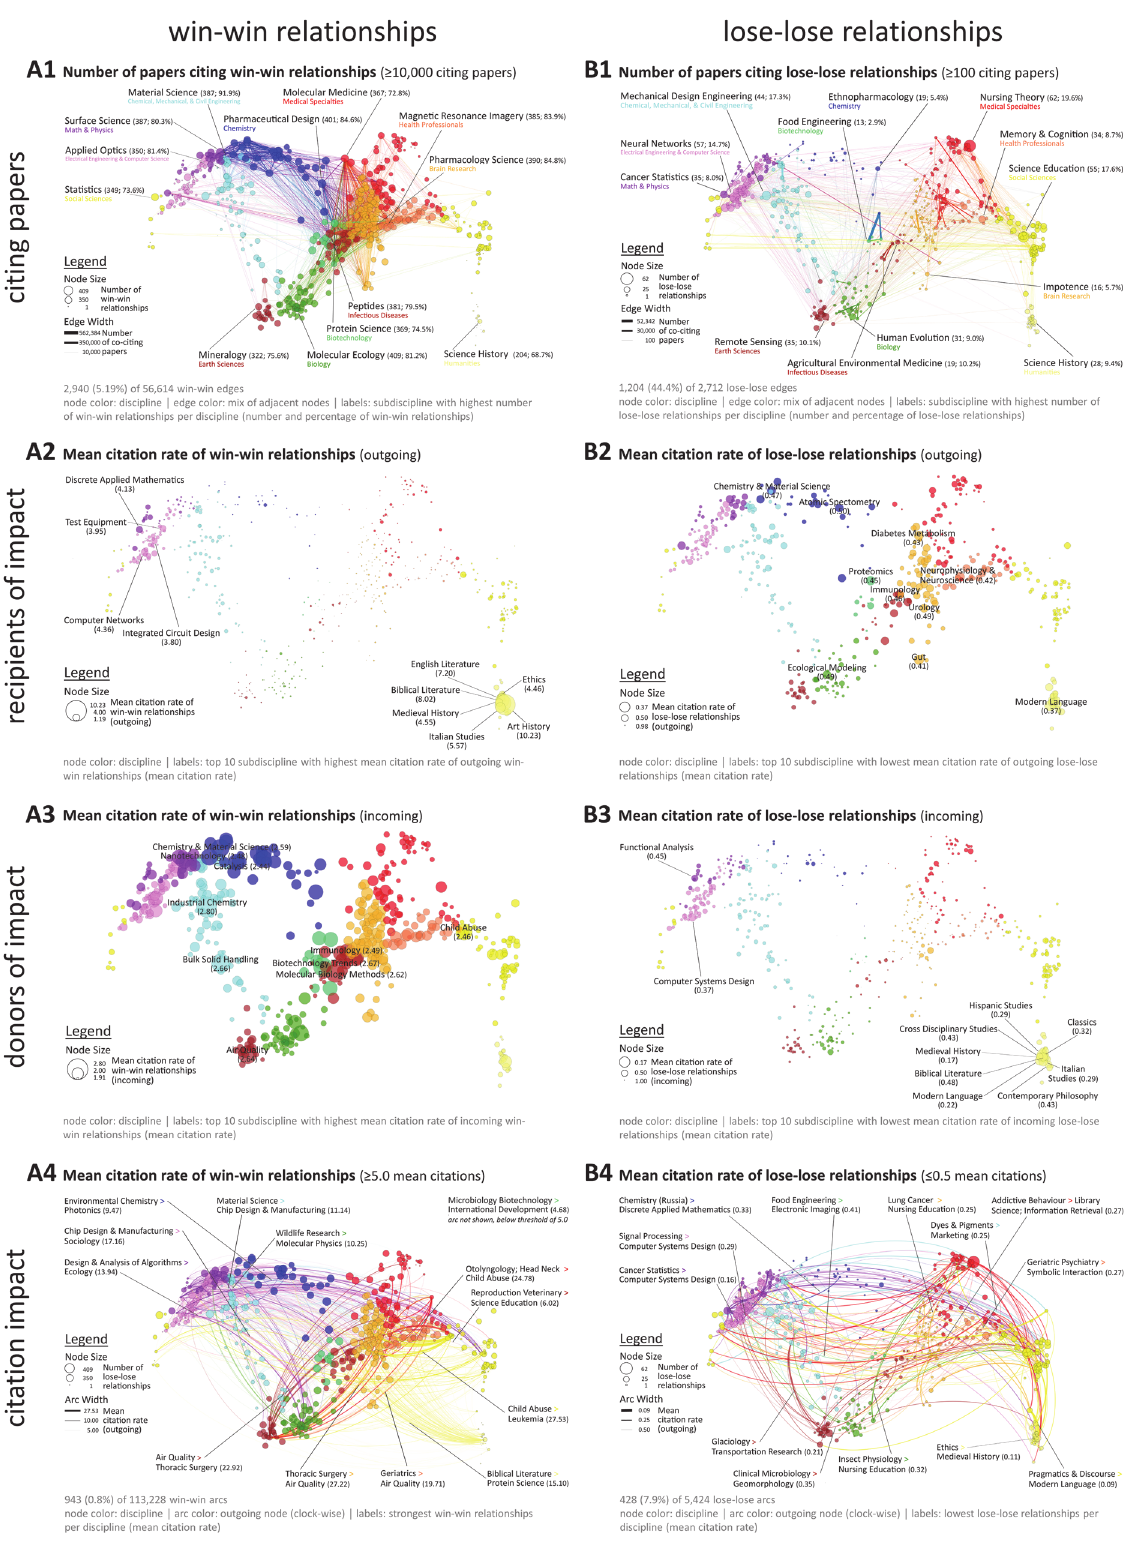
Fig 5. UCSD map overlay of win-win (A1-A4) and lose-lose (B1-B4) interdisciplinary combinations.